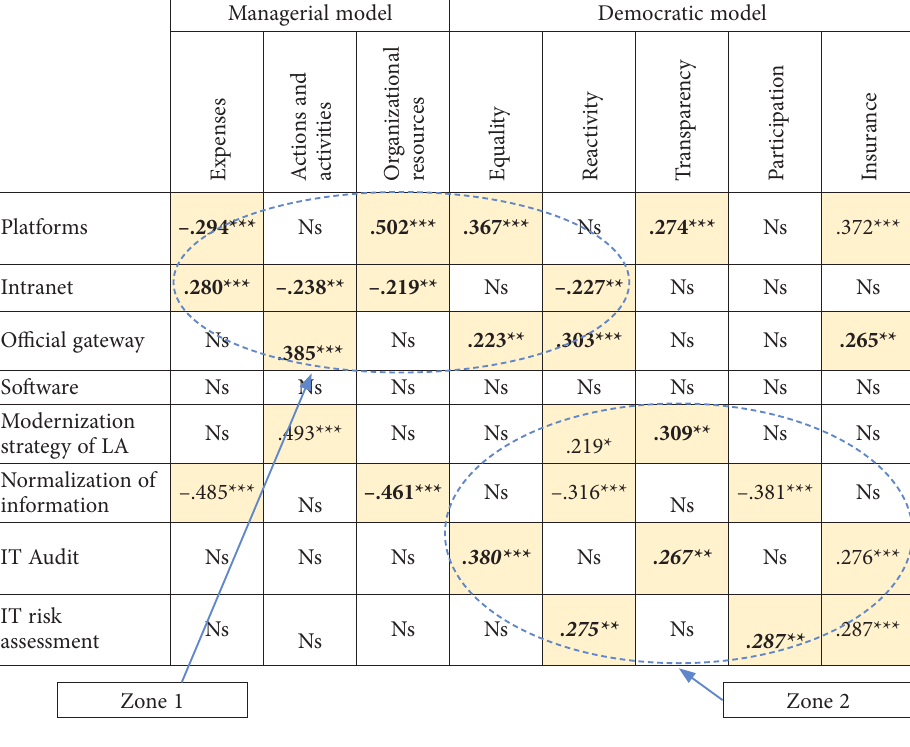
Table 2. Summary of Beta coefficients and thresholds of significance (source: author’s conception) Managerial